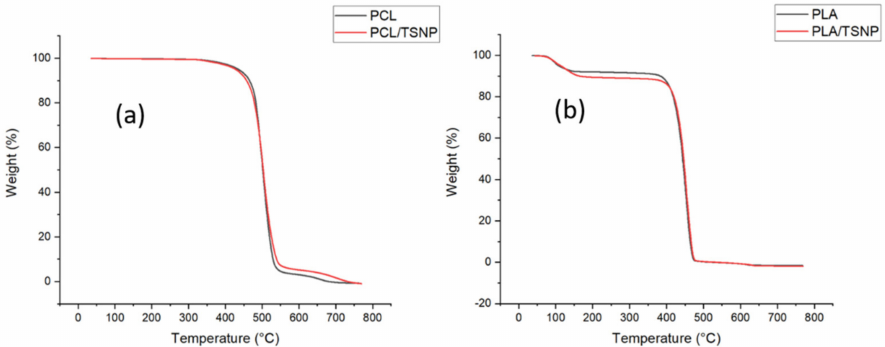
Figure 7. TGA curves of ( a ) bare and TSNP-treated PCL films, and ( b ) bare and TSNP-treated PLA films.